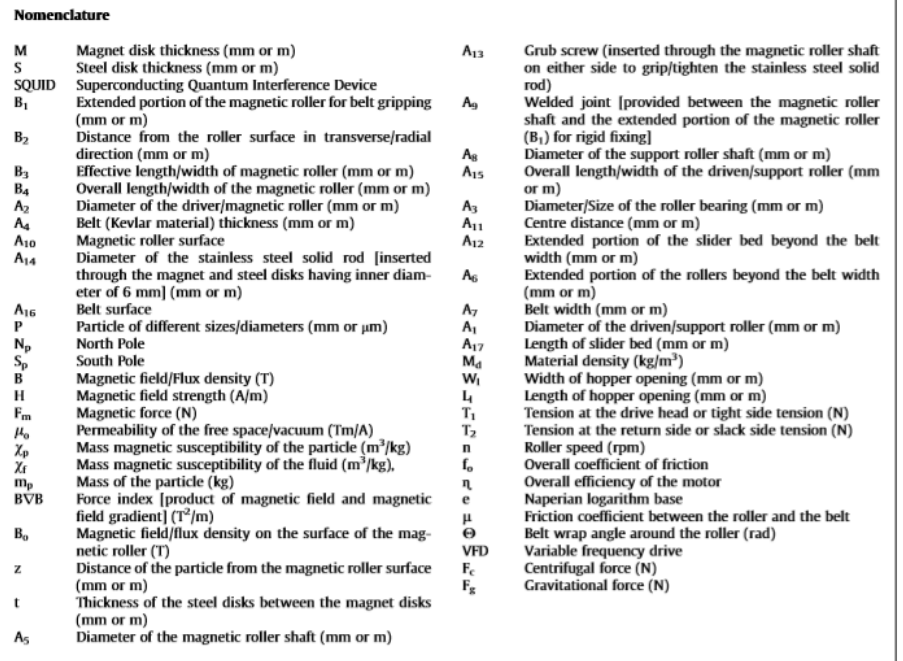
Figure 6. The influences of rare earth roll magnetic separator process parameters [30]. The magnet-to-steel disc thickness ratio (MSTR) is the key parameter of roll design that affects the strength and depth of the magnetic field. G.T. Mohanraj explored the magnetic field distribution of rolls with the help of the FEMM simulation software for different MSTRs. The simulation results are shown in Figure 7.